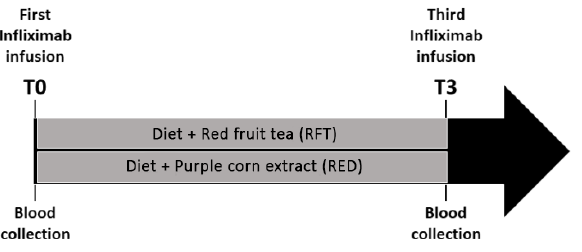
Figure 1. Experimental design: 47 enrolled IBD patients, before the first IFX infusion, were randomly assigned to 2 treatment groups (diet + RFT or RED).